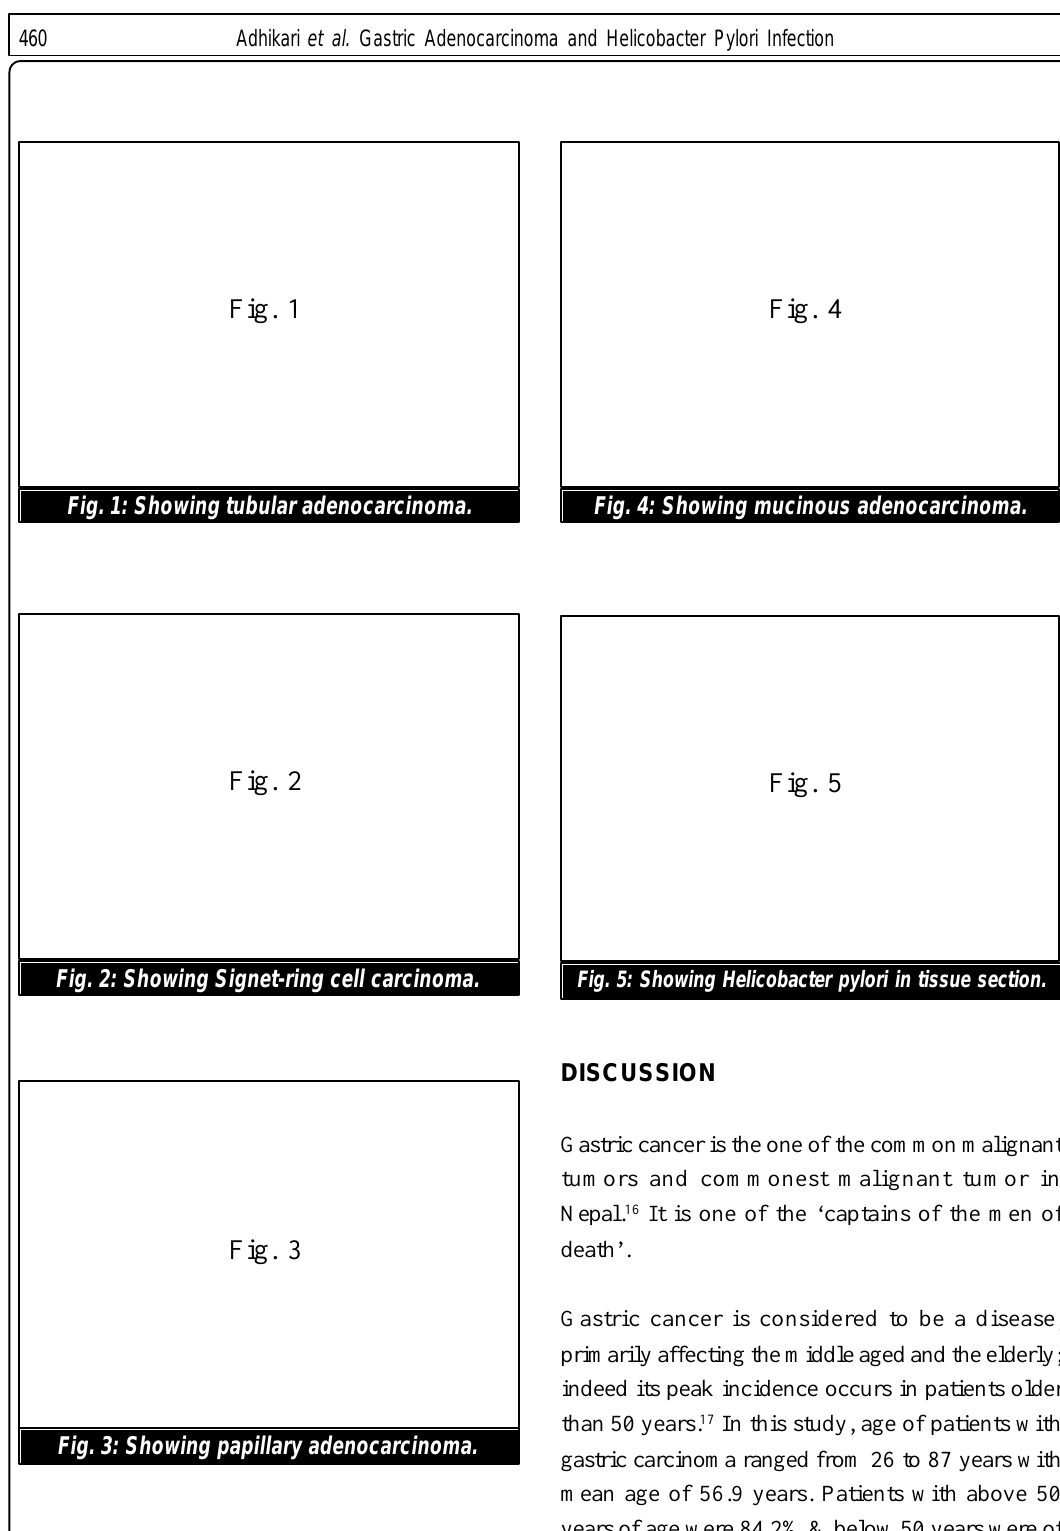
Fig. 3: Showing papillary adenocarcinoma.